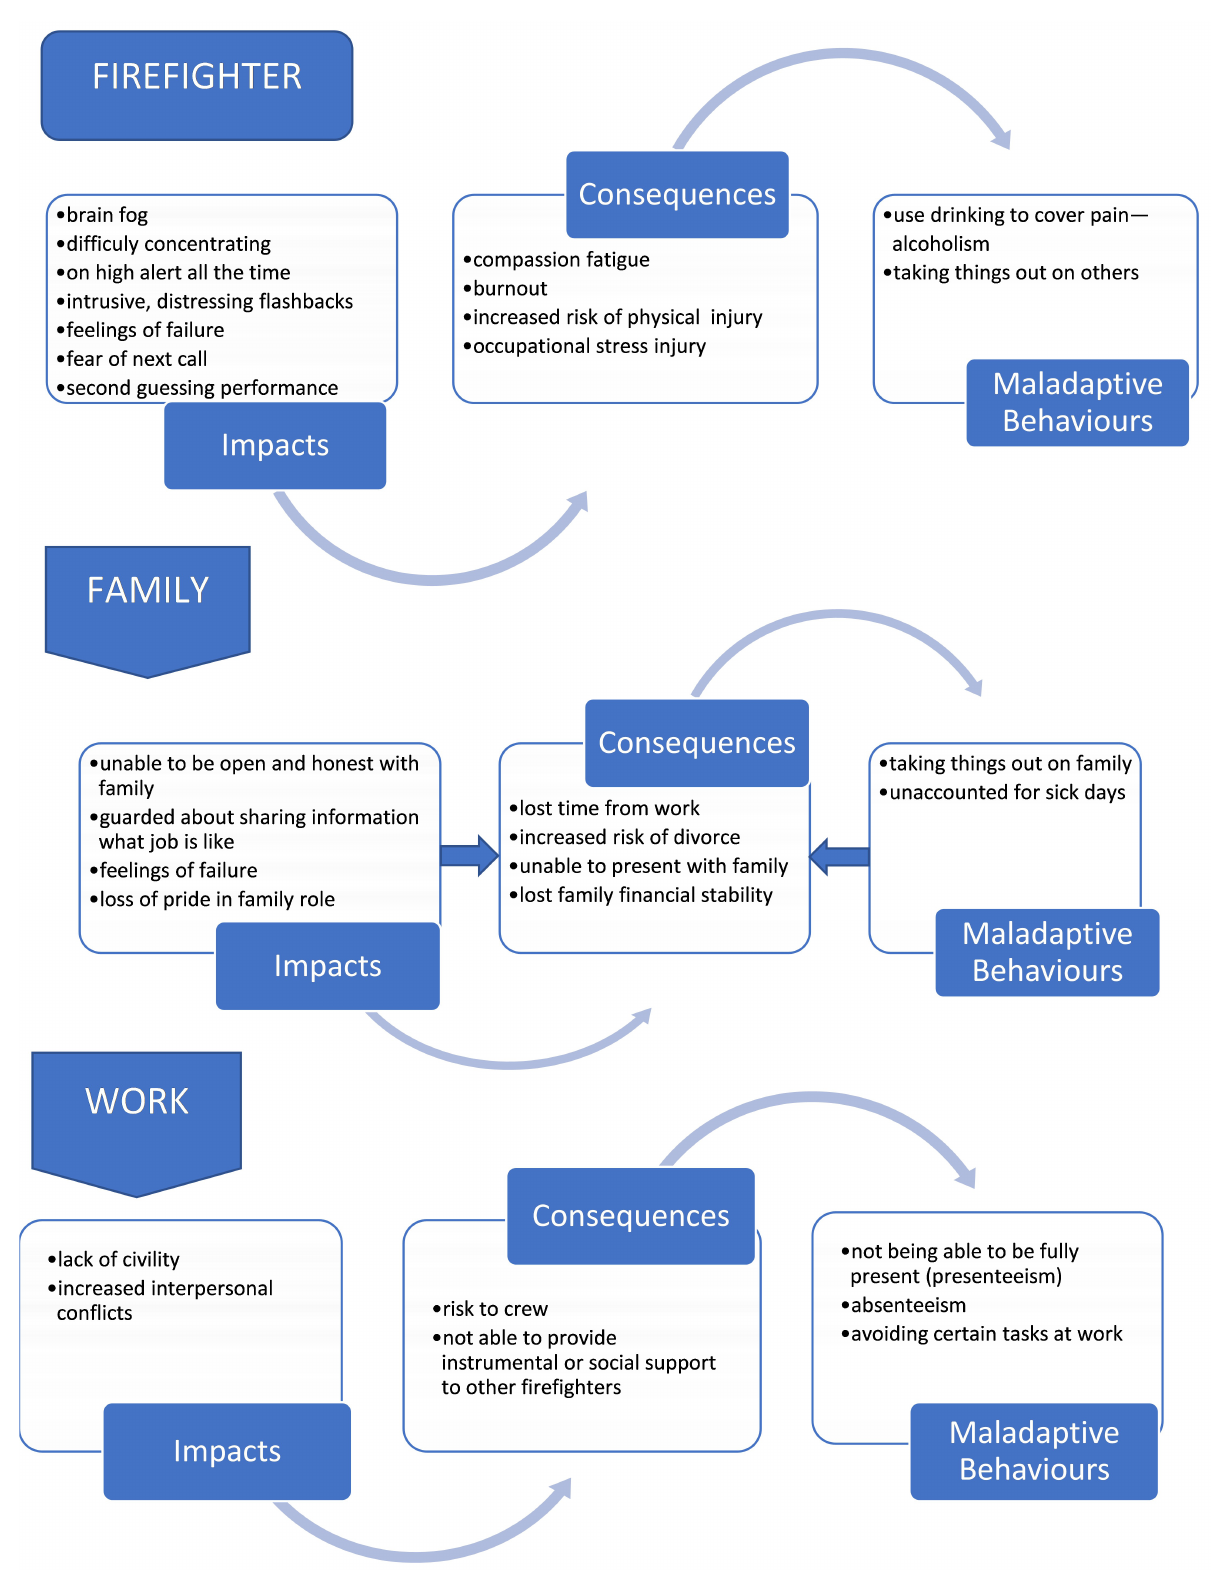
Figure 2. Impacts, Consequences, and Maladaptive Behaviours due to Occupational